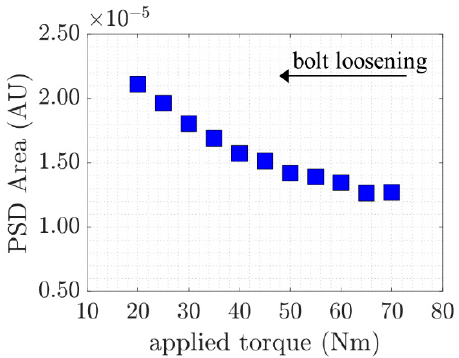
Figure 9. Combinational harmonic at sum frequency against applied torque.